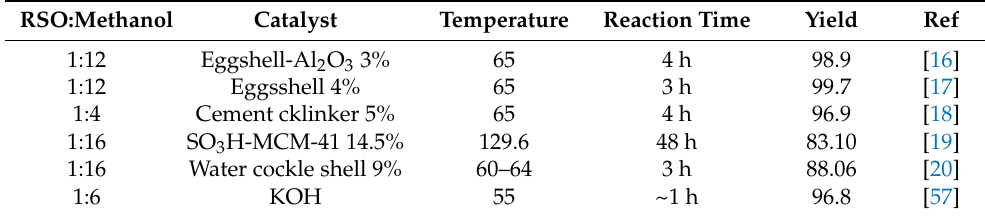
Table 3. Effect of process parameters on biodiesel